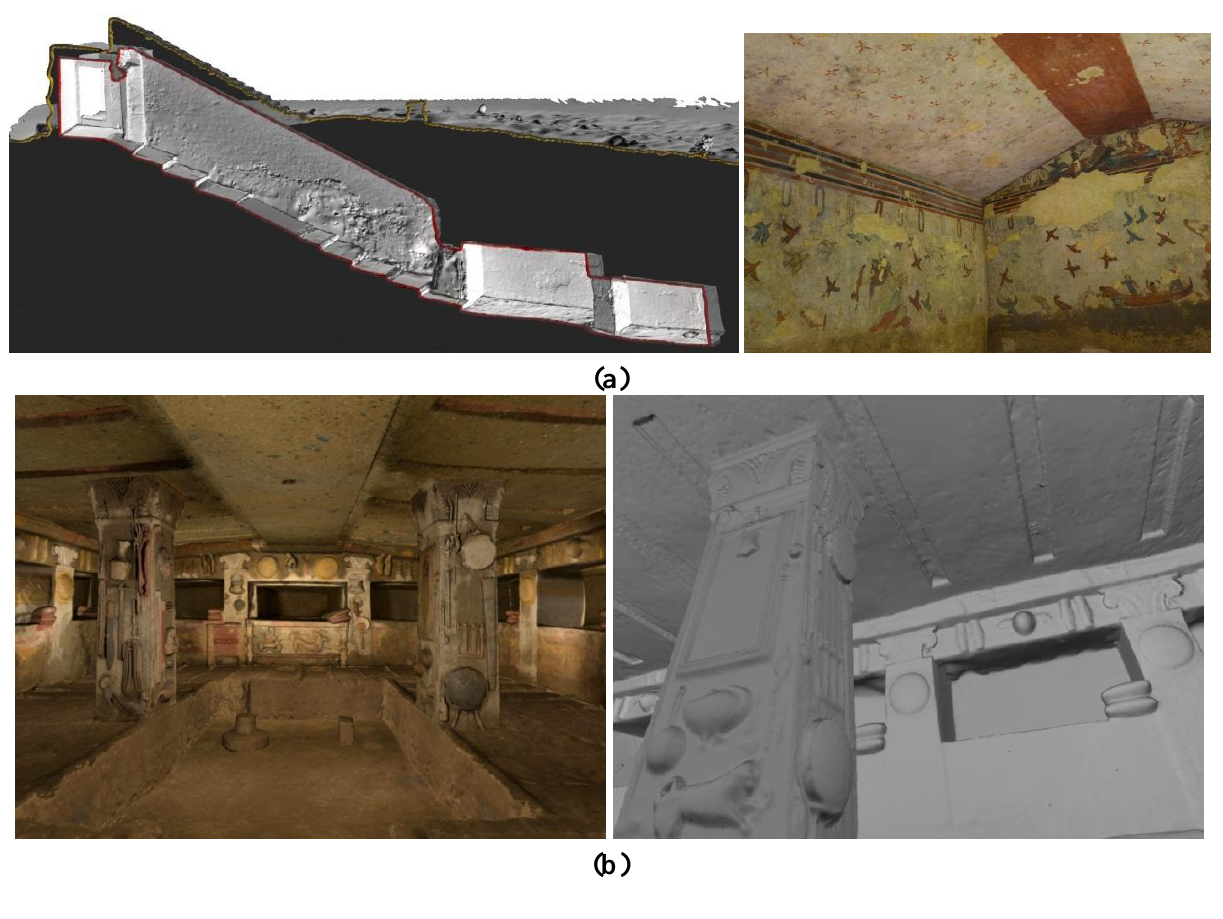
Figure 2. 3D surveying and modeling of frescoed underground Etruscan tombs for documentation, conservation, fruition and valorization purposes. (a) The ―Hanting and Fish‖ tomb in Tarquinia, Italy. (b) The ―Relief‖ tomb in Cerveteri,